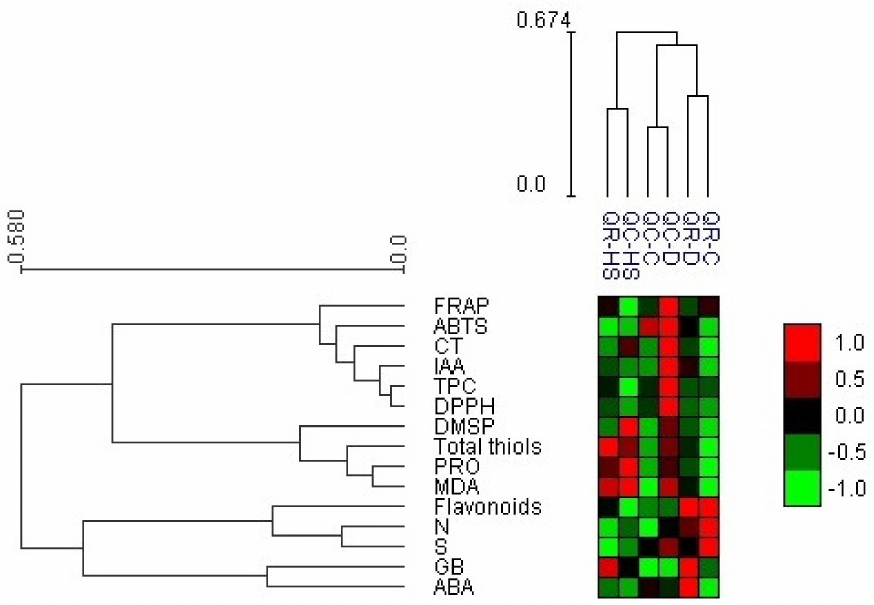
Figure 7. Heat map with bi-cluster analysis where red squares represent highly significant correlation of applied treatment and inspected parameter, while green squares present low interaction assessed according to corresponding Pearson’s coefficient. See legend of Figures 1 and 6 for abbreviations of the treatments and